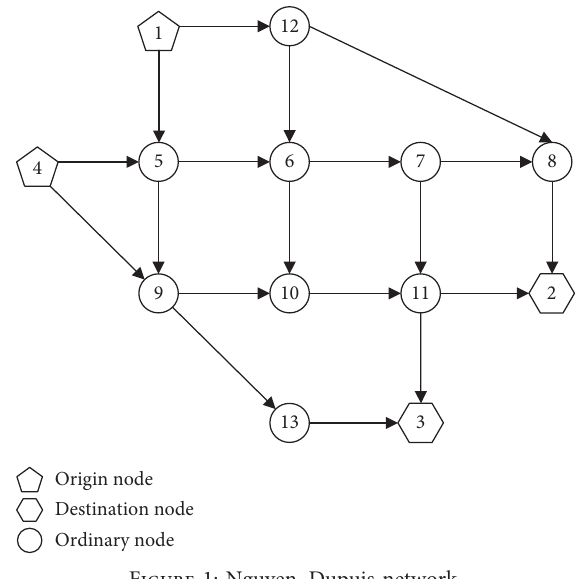
Figure 1: Nguyen–Dupuis network. Table 1: Link